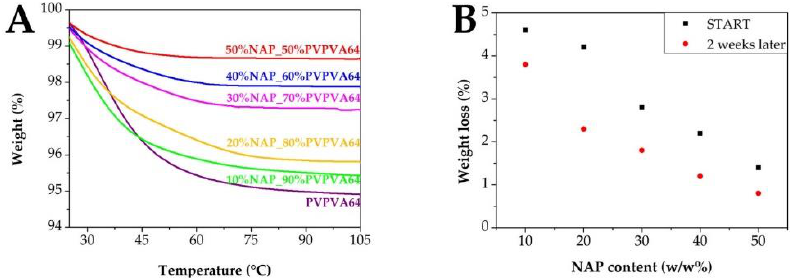
Figure 5. Investigation of the moisture content of the samples by TGA. ( A ) shows the changes in